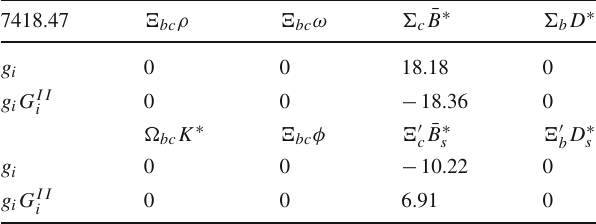
Table 18 Coupling constants to various channels and g i G II with q